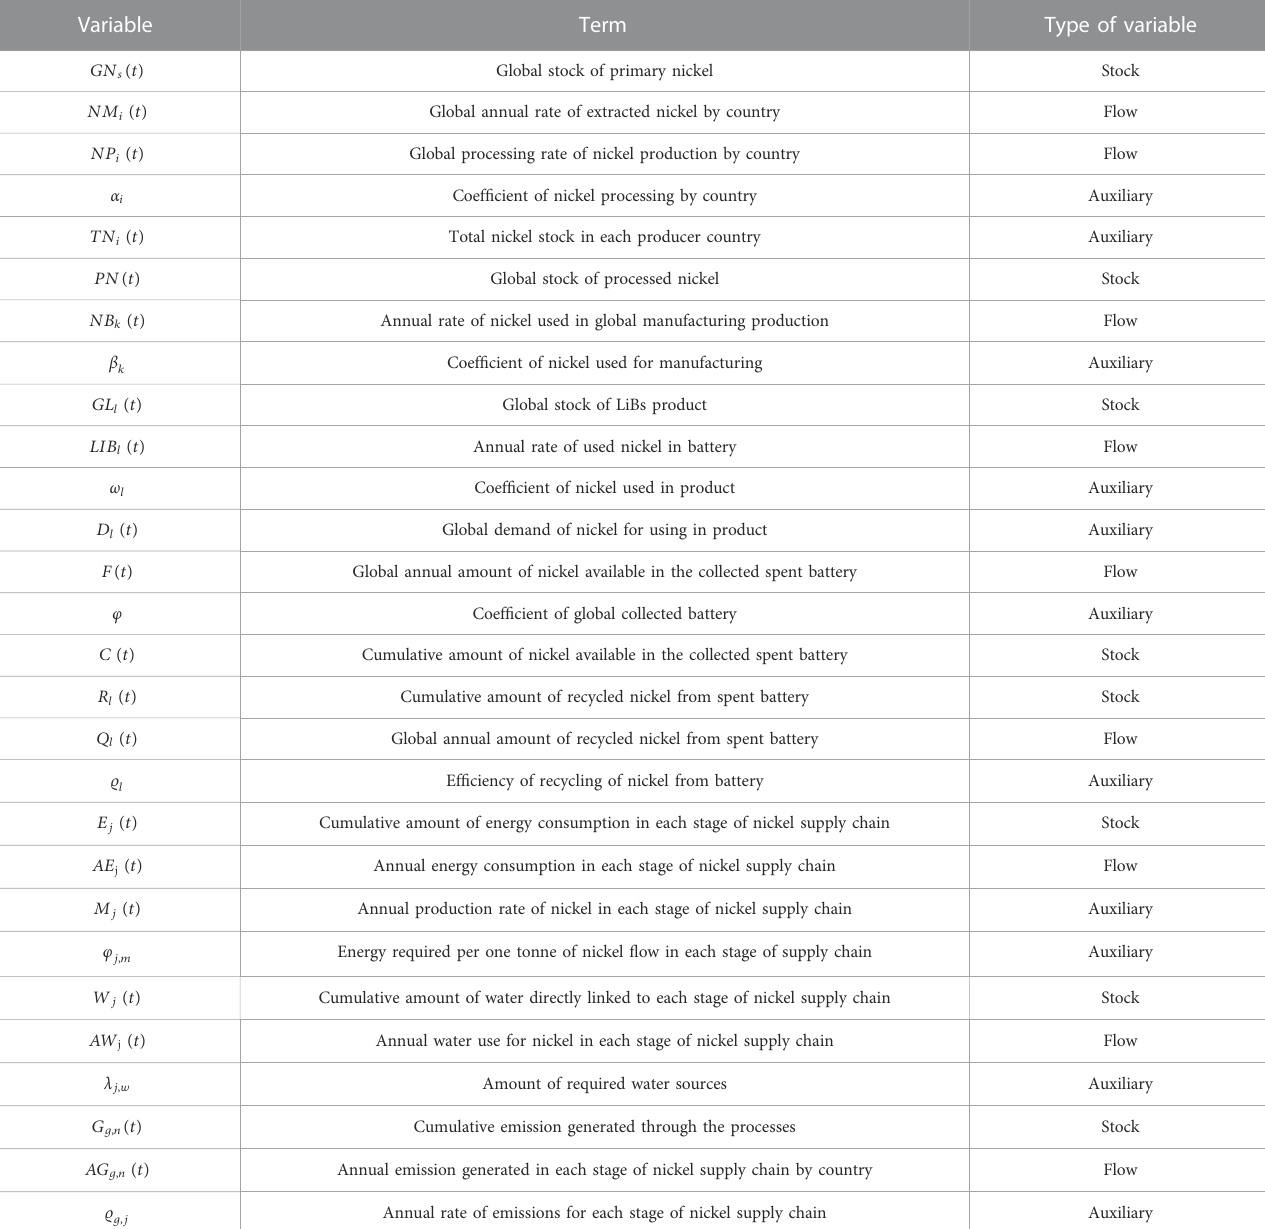
TABLE 2 Description of variables of the proposed dynamic model of nickel supply chain.